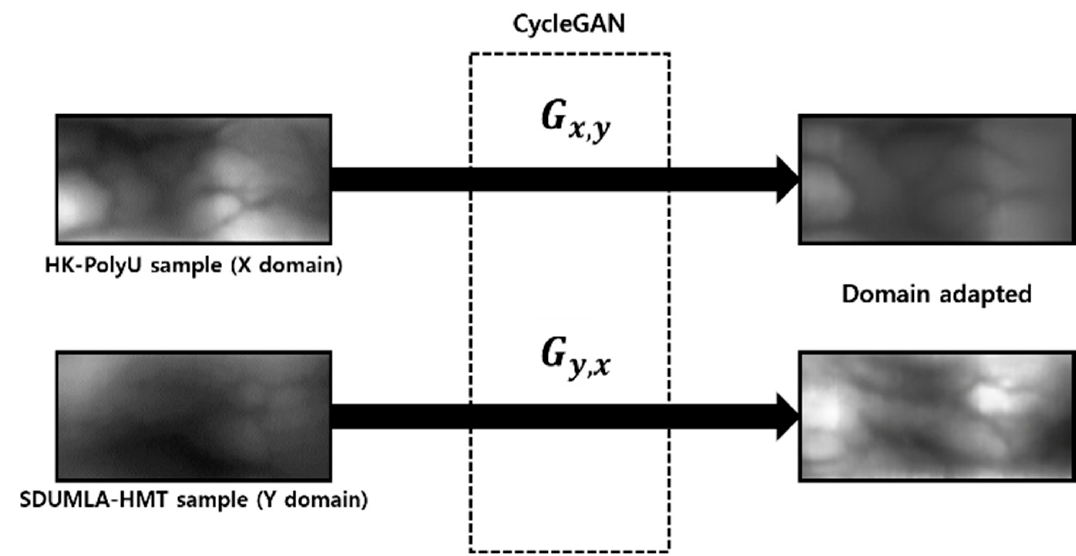
Figure 4. Examples of the domain translated image.